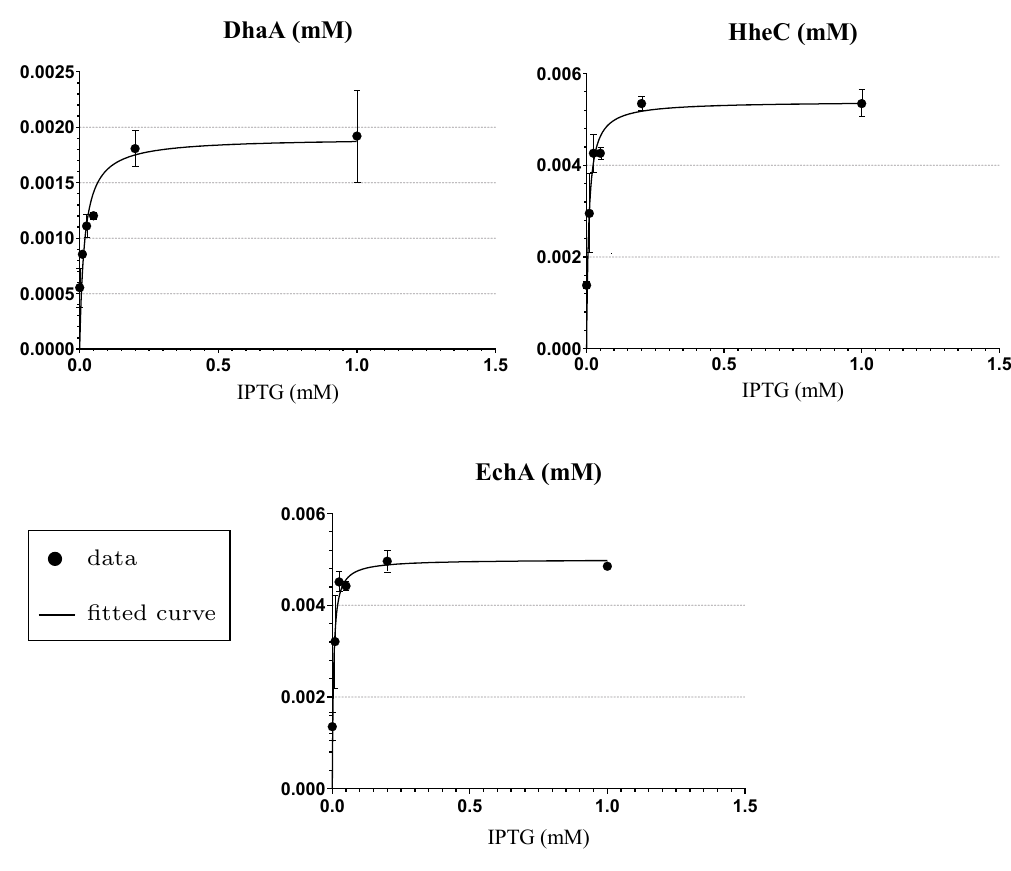
Figure 5. Results of fitting to enzymes concentration data. Three plots show individual results of fitting to concentration data measured in various starting concentration levels of the inducer (IPTG 0 )—0.0, 0.01, 0.025, 0.05, 0.2 and 1.0 (mM)—for three different enzymes: DhaA ( top left ); HheC ( top right ); and EchA ( bottom ). The experimental data are pictured as points and the results—fitted curves—are pictured as lines. Both axes show a concentration level in mM, the inducer on the x-axis and the particular enzyme on the y-axis of the particular plot. Error bars represent standard deviation values calculated from two independent